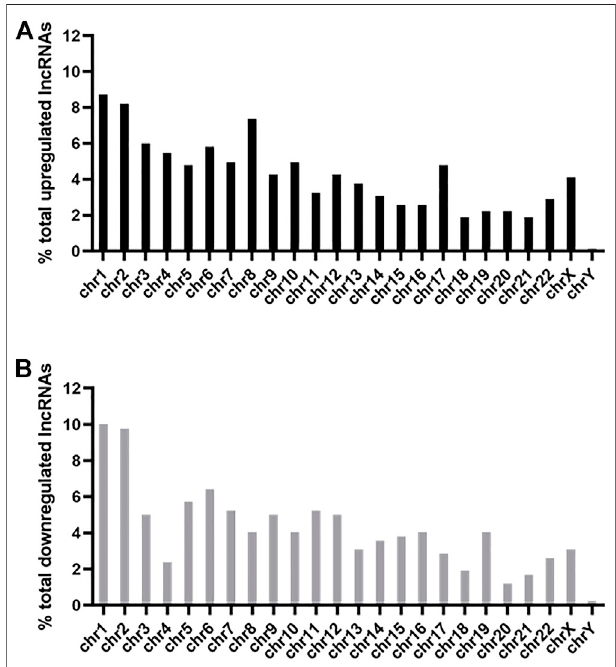
FIGURE 3 | Chromosomal distribution of differentially expressed lncRNAs. The upregulated (A) and downregulated (B) lncRNAs were widely distributed among all chromosomes, including the sex chromosome X and chromosome Y.